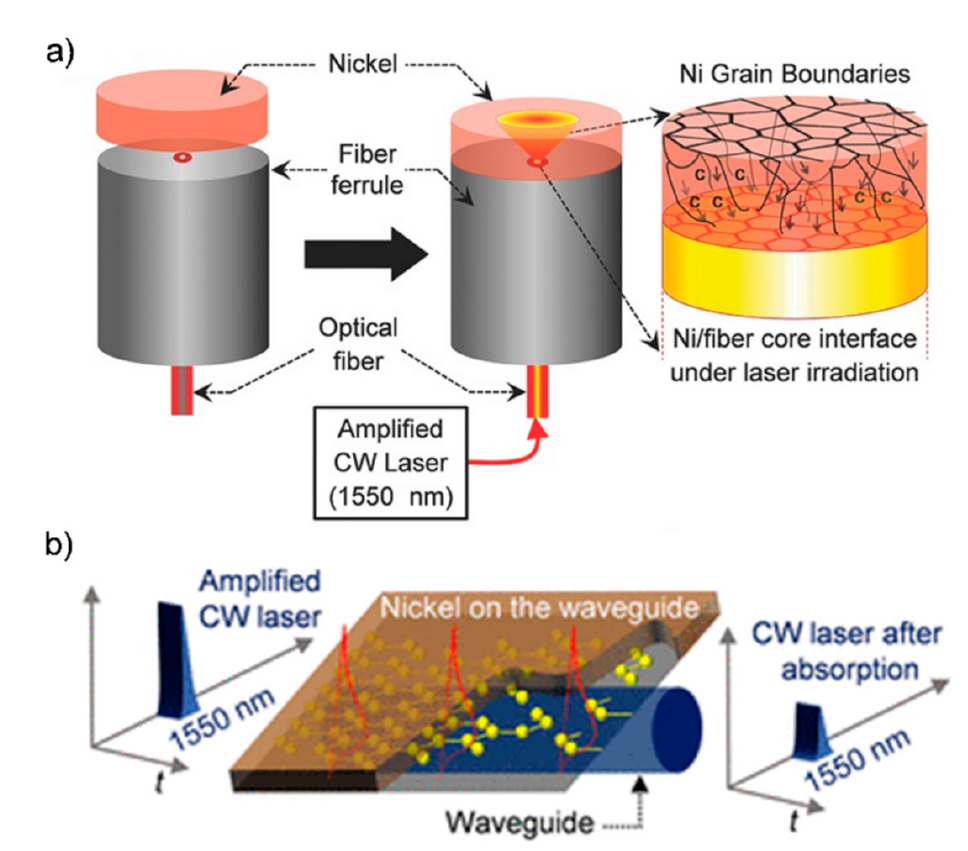
Figure 3. ( a ) Schematic representation of the laser induced synthesis of graphene by the in-situ method onto SMF end facet; ( b ) Schematic illustrations of in-situ synthesis of graphene onto the flat surface of a D-shaped fiber. ( a ) Reproduced with permission from [82]. Copyright WILEY-VCH Verlag GmbH & Co. KGaA, Weinheim, 2015. ( b ) Reproduced with permission from [83]. Copyright American Chemical Society,